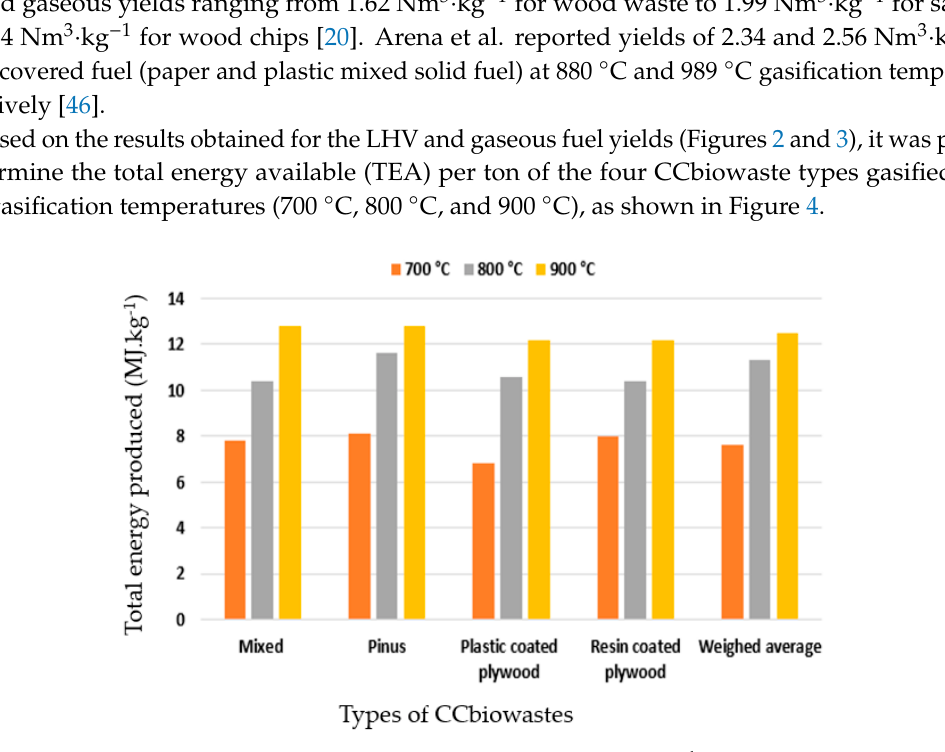
Figure 4. Effect of temperature on the total energy available (TEA) (MJ ∙ kg − 1 ) of the gasified CCbiowaste.